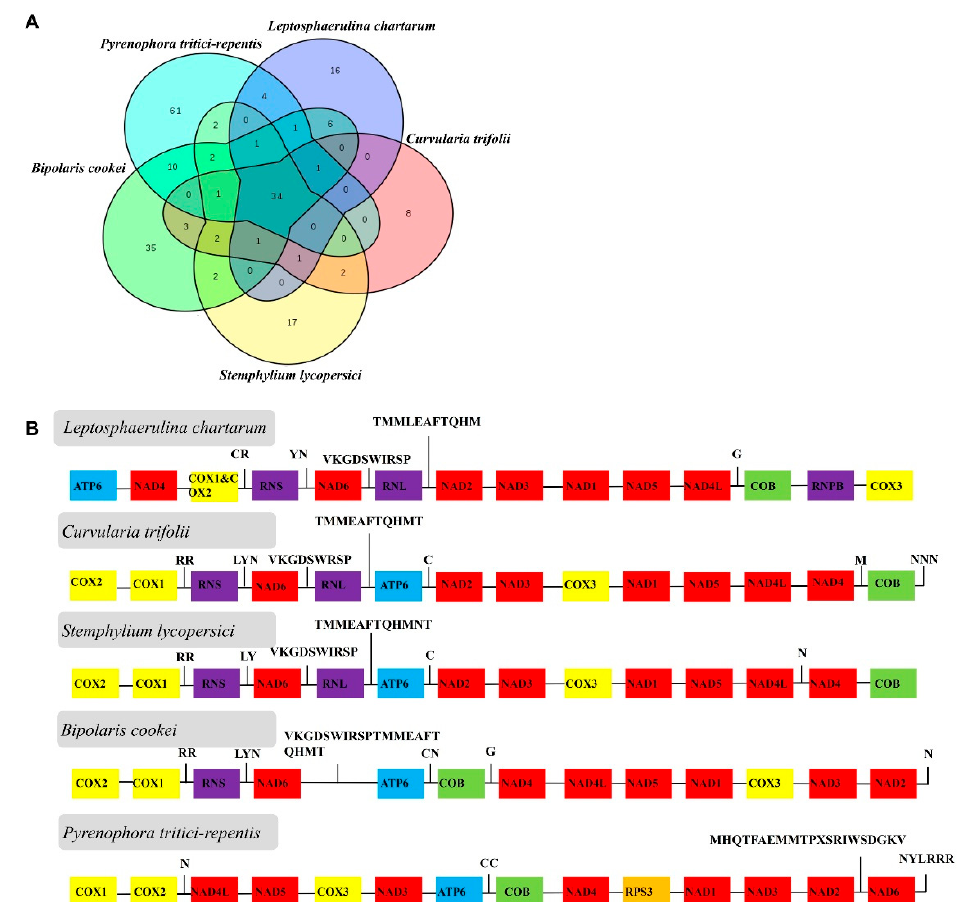
Figure 4. Comparison of the mitogenome components in L. chartarum , C. trifolii and related species. ( A ) Gene content comparison among Pyrenophora tritici-repentis , L. chartarum , C. trifolii , Bipolaris cookei , Stemphylium lycopersici mitogenomes. ( B ) Comparative analysis of nucleotide sequences for each protein-coding gene, two ribosomal DNA genes among Pyrenophora tritici-repentis , L. chartarum , C. trifolii , Bipolaris cookei , Stemphylium lycopersici. The same genes are marked with the same color.